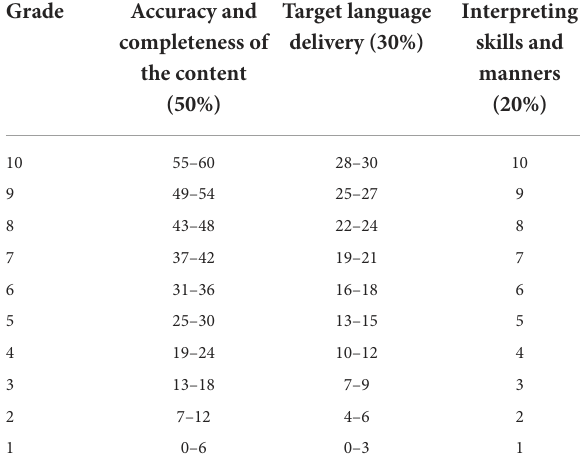
TABLE 4 Comparison of the grade transformation of the rating results.